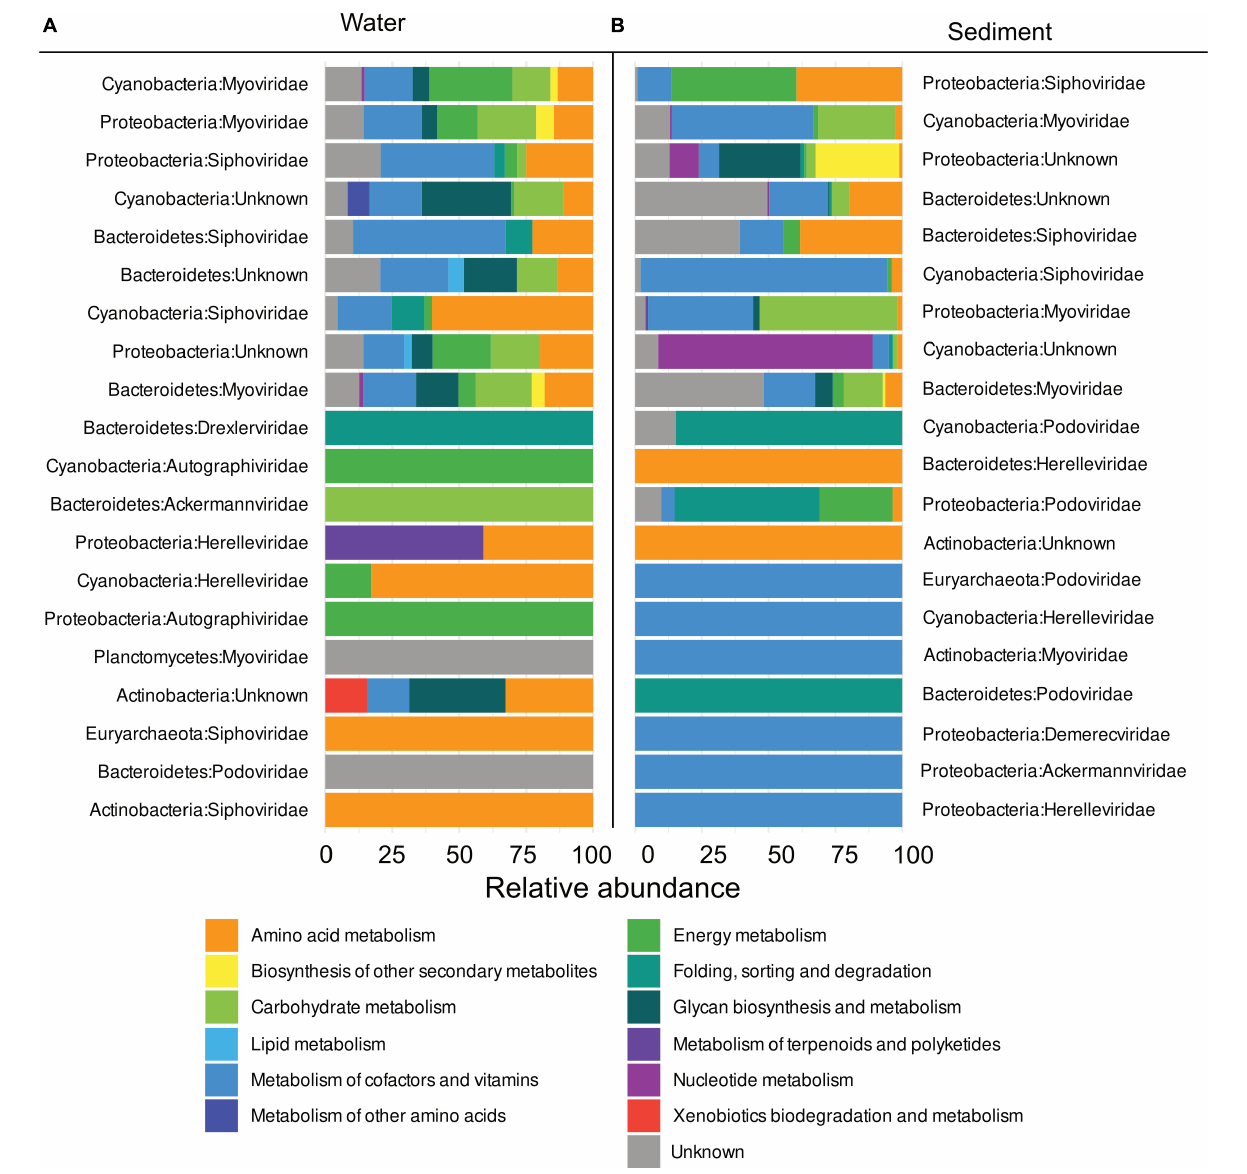
FIGURE 7 | Relative abundance of metabolic pathways per host phylum and viral family in descending order by the sum of total FPKM assigned to metabolic pathways in (A) the water columns and (B)